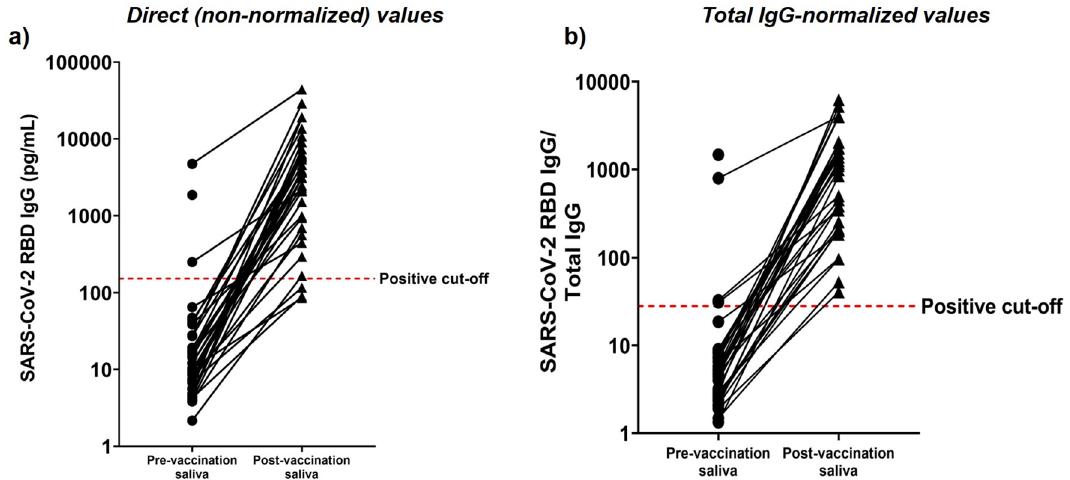
Figure 3. Distribution of SARS-CoV-2 spike protein RBD IgG antibody levels in pre- and post-COVID-19 vaccination unconcentrated saliva samples measured using a Simoa immunoassay with and without total IgG normalization. The levels of SARS-CoV-2 RBD IgG were measured in the saliva from 36 pre-vaccinated individuals and 34 post-vaccinated individuals. The positive cut-off was 153 pg/mL. ( a ) Direct (non-normalized) values. ( b ) RBD IgG values (in ng/mL) normalized to total IgG levels (in ng/mL) and multiplied by